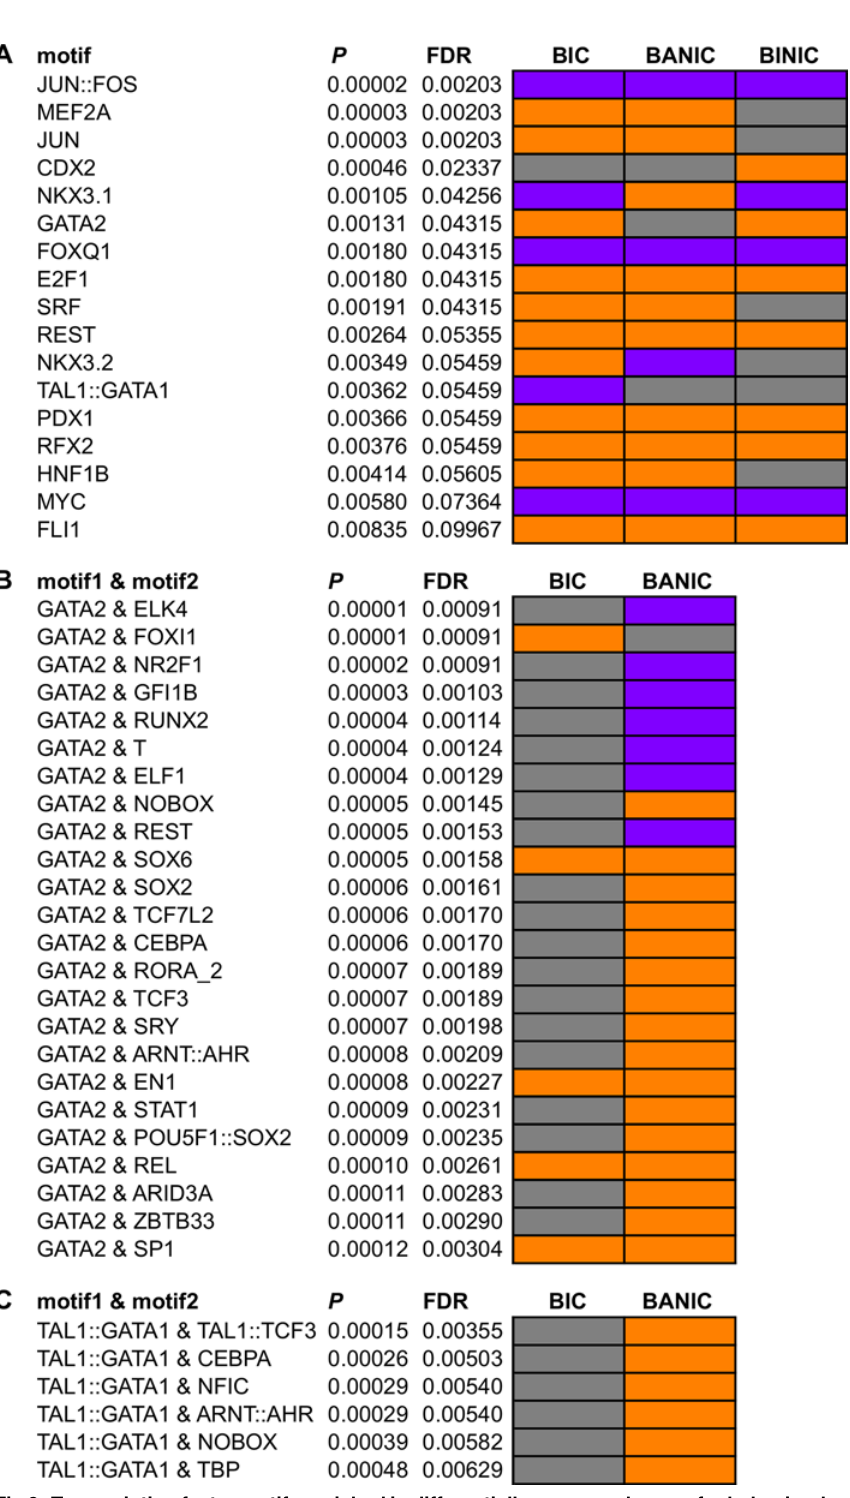
Fig 3. Transcription factor motifs enriched in differentially expressed genes for behavioral groups. (A) Single motifs enriched in at least one of the behavioral groups (BIC, bystanders to interacting conspecifics; BANIC, bystanders attentive to non-interacting conspecifics; or BINIC, bystanders inattentive to non- interacting conspecifics). (B) Pairs of motifs involving GATA2 enriched in BIC and/or BANIC. (C) Pairs of motifs involving TAL1::GATA1 enriched in BIC and/or BANIC. Associations found in each behavior group can